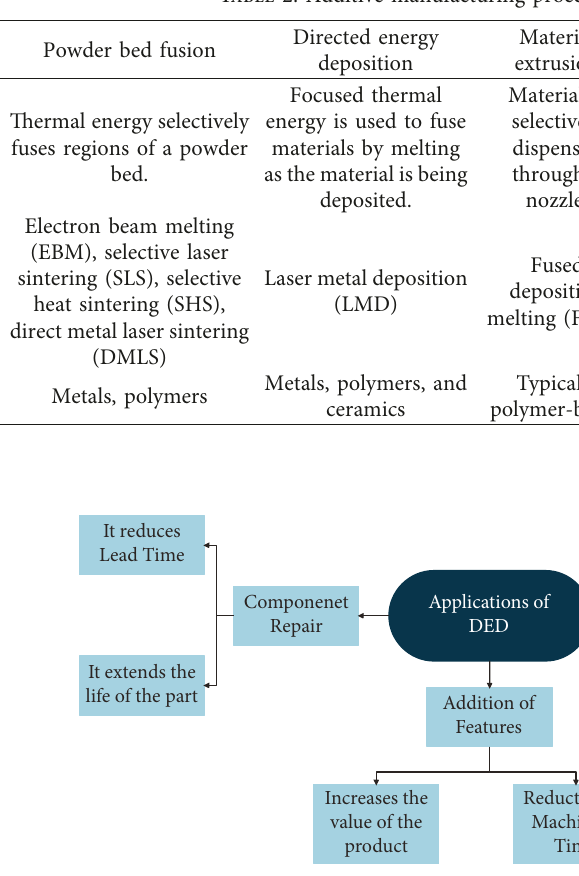
Table 2: Additive manufacturing processes (comparisons).